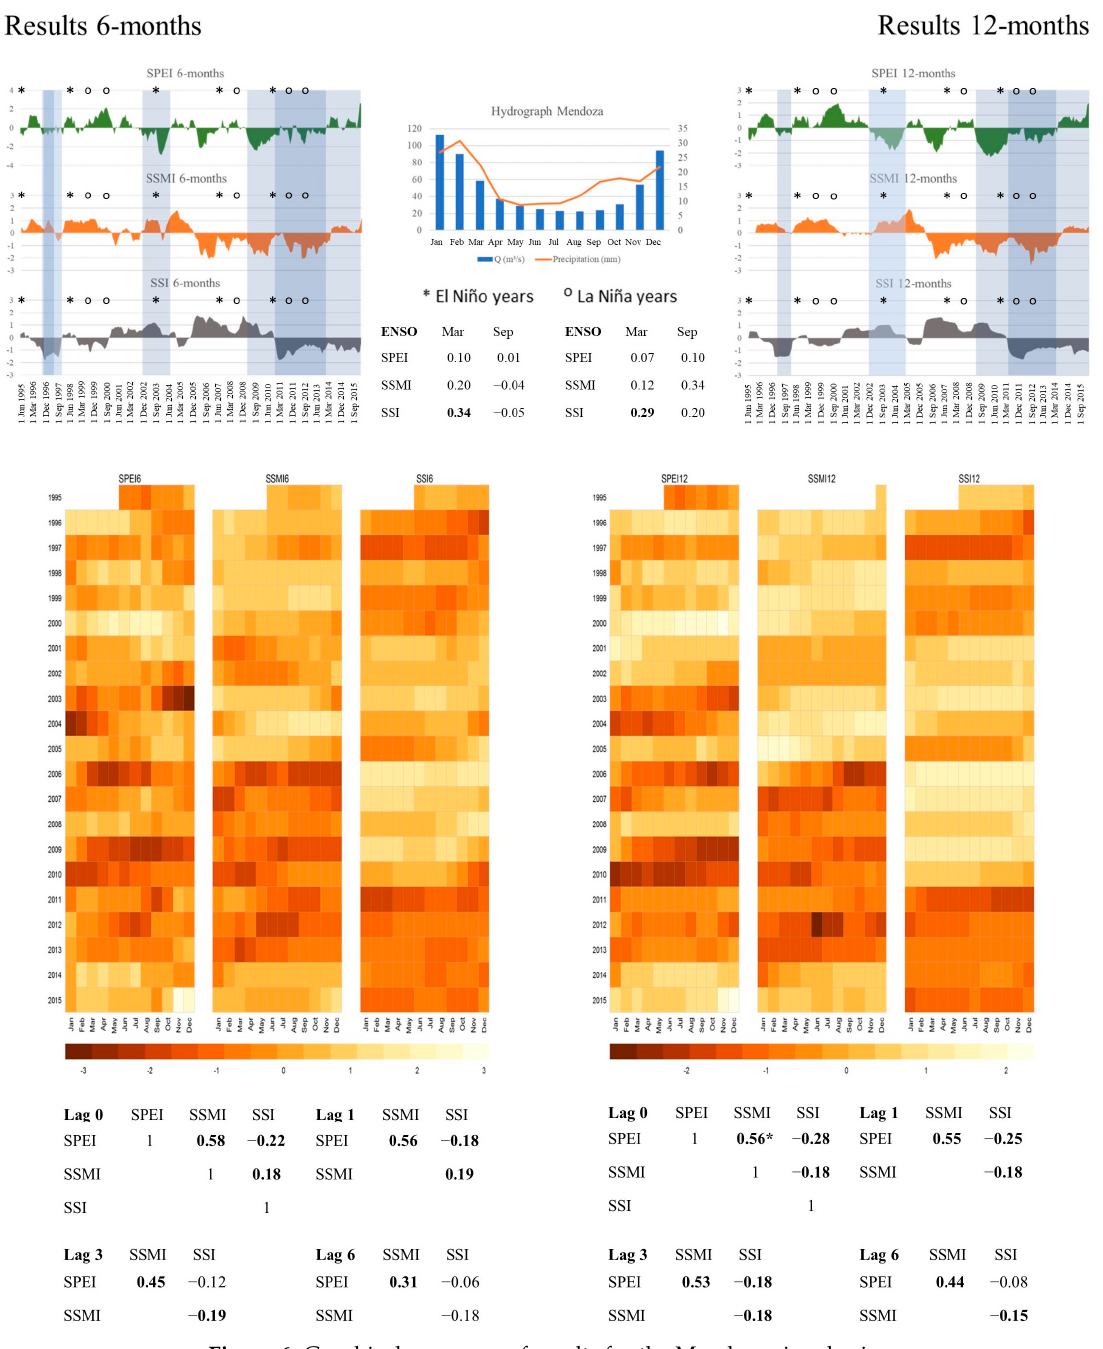
Figure 6. Graphical summary of results for the Mendoza river basin.